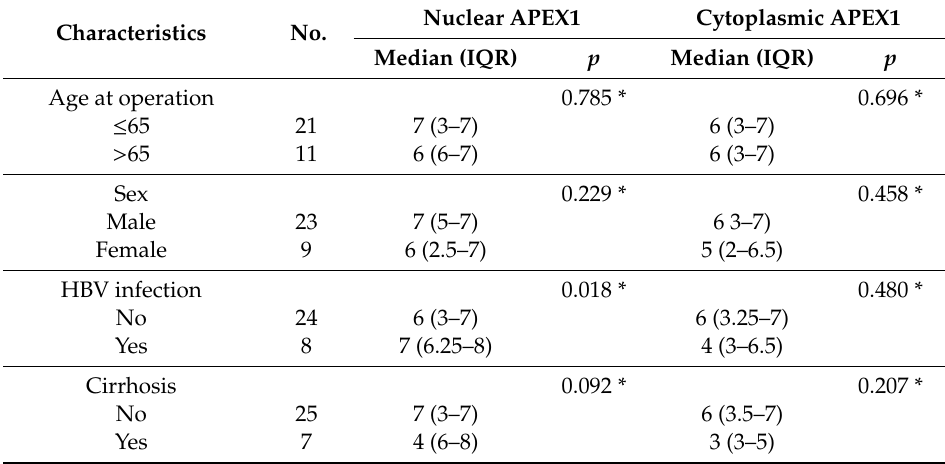
Table 4. Summary of the clinicopathologic characteristics of patients with primary intrahepatic cholangiocarcinoma ( n =